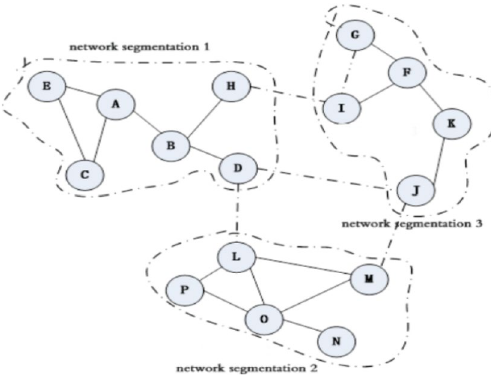
Figure 1. DTN network partitions.